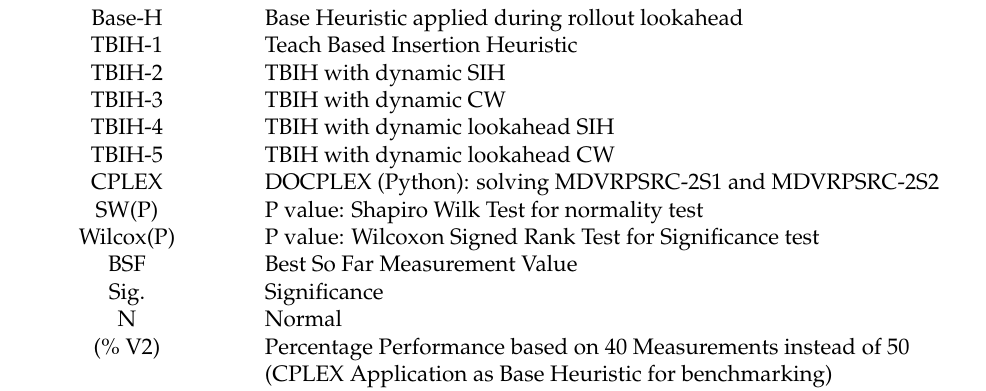
Table 5. Abbreviation for Tables and